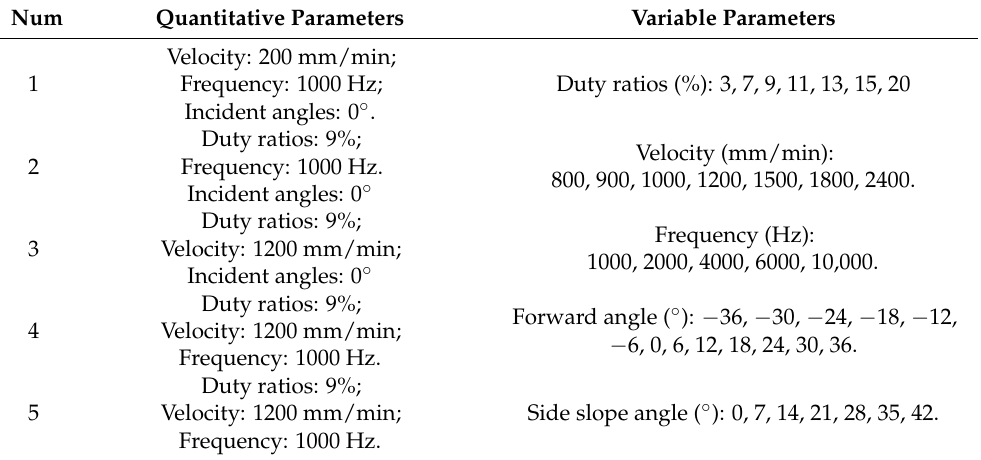
Table 2. Test parameters of laser